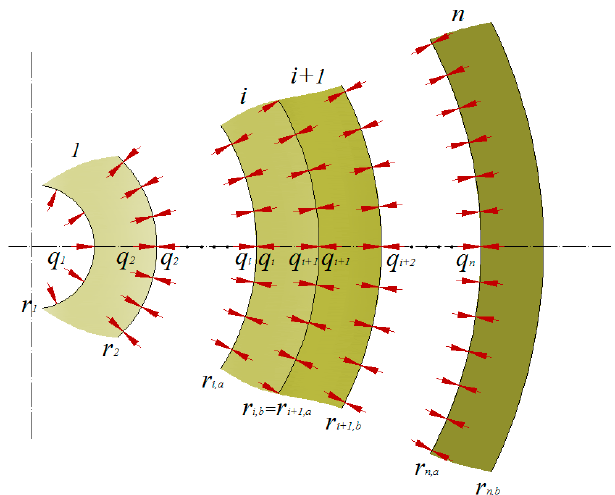
Figure 3. Model of a multi-layer pipe under internal pressure assumed for the calculations, where r—radius, i—layer, q—inter-layer pressure. r —radius, i —layer, q —inter-layer